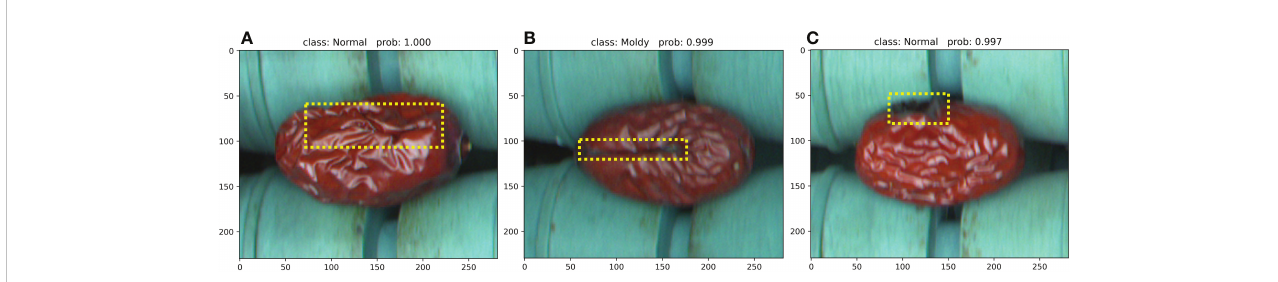
FIGURE 10 Examples of failure cases. The yellow dashed boxes indicate the defect areas that the model needs to focus. (A) A deformation defect was mistaken for a normal jujube. (B) A crack defect was mistaken for a moldy defect. (C) A moldy defect was mistaken for a normal jujube.